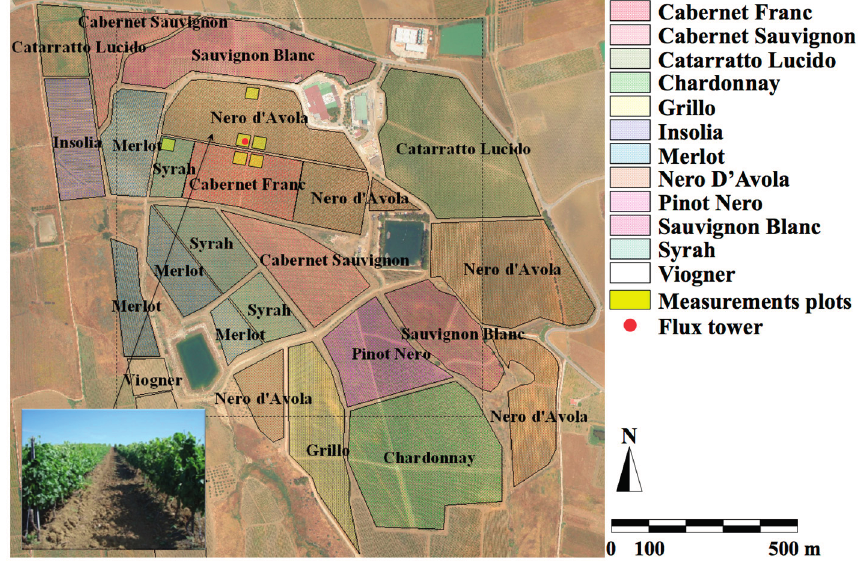
Figure 4. The study area included: vine cultivars (reported on the right side legend); the flux tower position (red dot), in situ measurements plots (highlighted in yellow); airborne image footprint (dashed black rectangle); canopy management (vertical trellis system) (lower-left